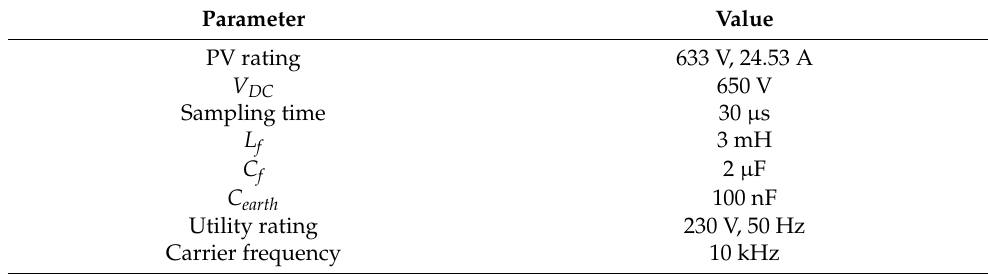
Table 1. System settings and